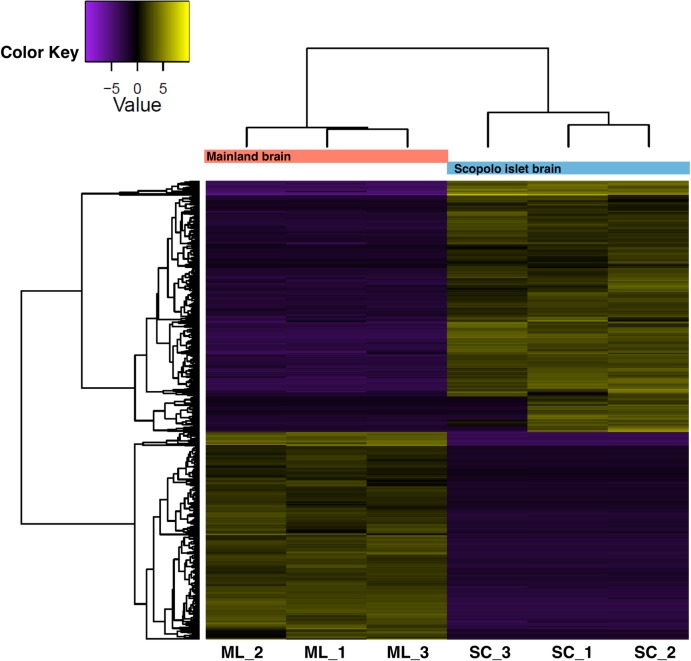
Heatmap of differential gene expression between mainland lizards and island lizards.Heatmap shows the expression of transcripts that were differentially expressed in mainland lizard brains (ML) and island lizard brains affected by RIS (SC). The heatmap gives a graphical representation of the expression level of the up and down regulated transcripts between Scopolo (SC) and mainland (ML) populations due to two the different environments. Each row corresponds to a transcript, and each column corresponds to a sample. Hierarchical clustering of differentially expressed transcripts (FDR < 0.001; FC>2) are shown from adult males of mainland (orange cluster) and Scopolo (azure cluster) specimens. Violet cells correspond to lower than average expression, and yellow cells correspond to higher than average expression.